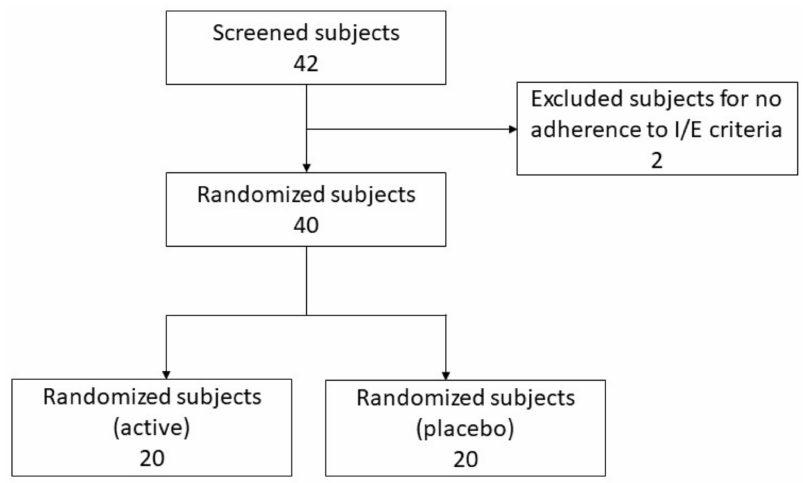
Figure 1. Study flow chart.